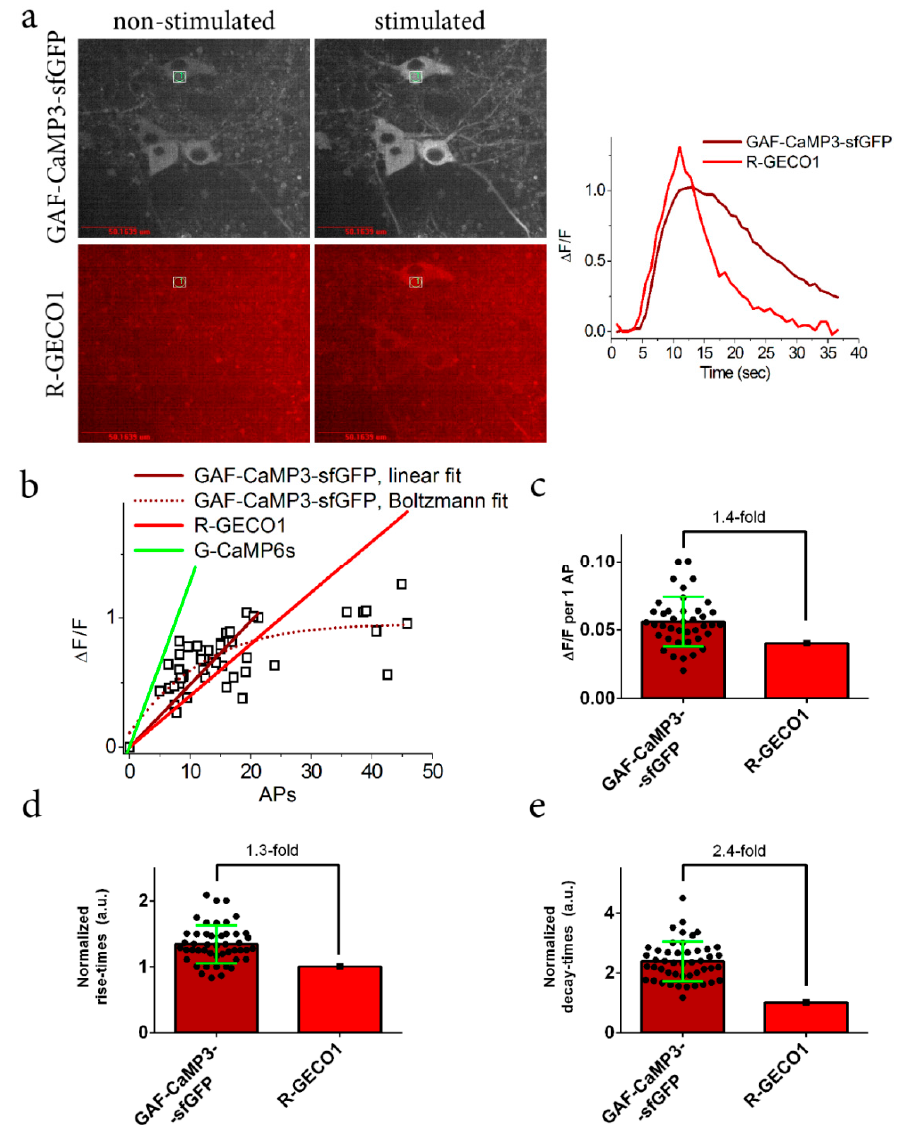
Figure 5. Comparison of the responses of the near-infrared GAF-CaMP3–sfGFP and the red R-GECO1 indicators to the external field stimulation of neurons co-expressing the genetically encoded calcium indicators (GECIs) in dissociated neuronal cultures. Neuronal cultures co-expressing the NES-GAF-